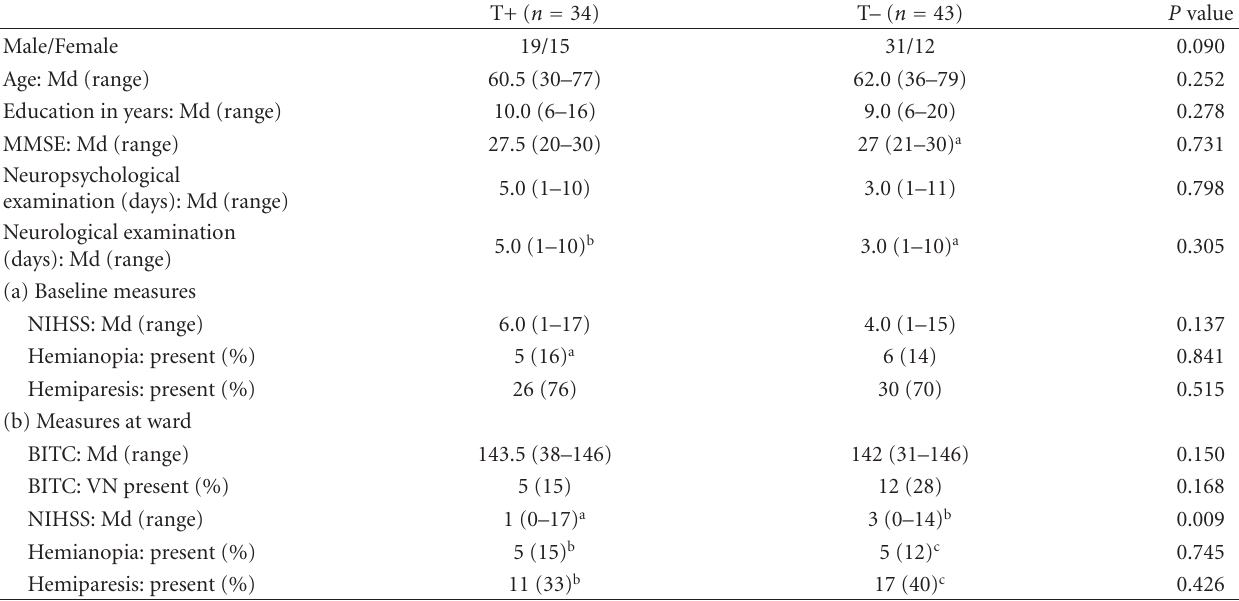
Table 1: Clinical characteristics of patients with (T+) and without thrombolysis (T − ) and the comparison between the